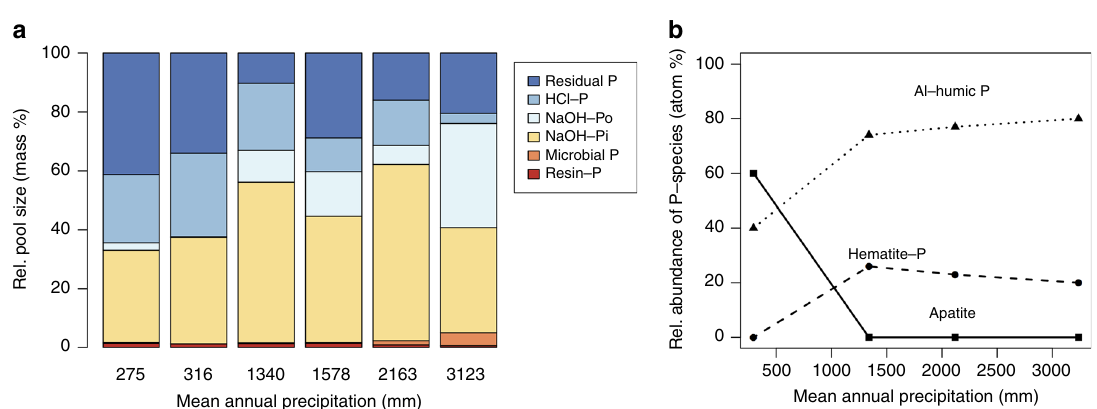
Fig. 1 Phosphorus pool distribution along the climatic gradient. Relative concentration of P pools, as determined by sequential extraction ( a ) and of P classes by bulk P K-edge X-ray absorption near-edge structure (XANES) ( b ). Measured concentrations are in the supplemental material (Supplementary Table 2). XANES was performed at four sites along the gradient ( b ). XANES relative abundances are accurate to ±10% with a detection limit of around 10%